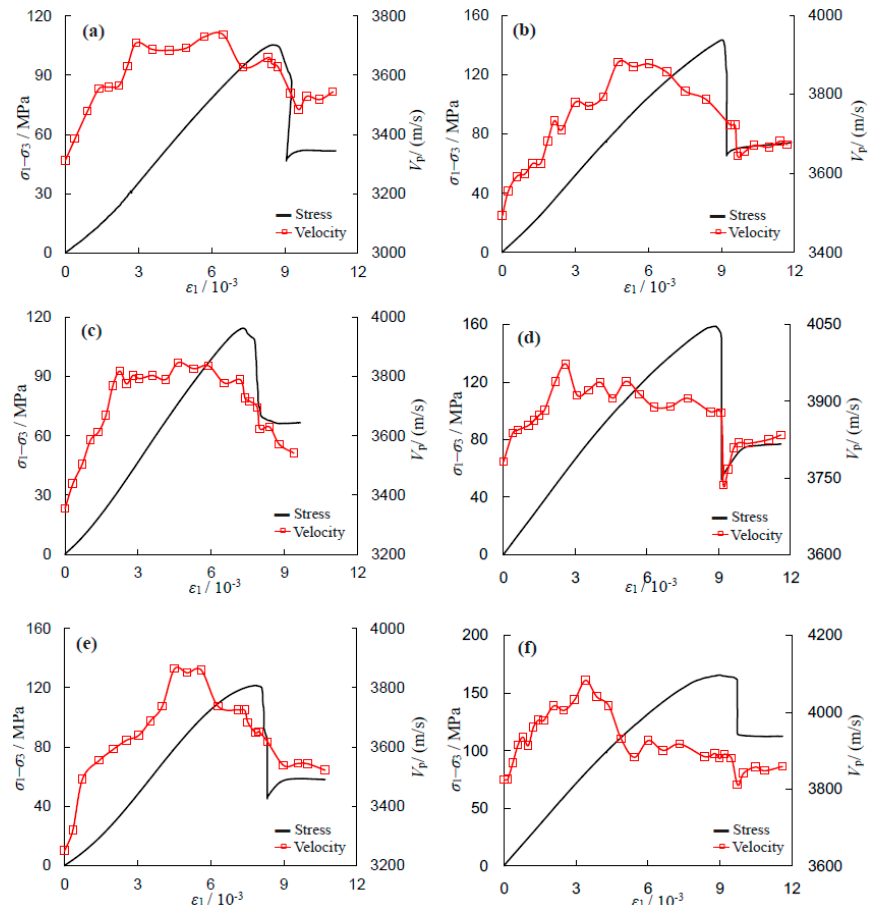
Figure 10. P-wave velocity against axial strain during complete failure process under triaxial compression. ( a ) Water, σ 3 = 10 MPa; ( b ) Water, σ 3 = 60 MPa; ( c ) 10% NaCl, σ 3 = 10 MPa; ( d ) 10% NaCl, σ 3 = 60 MPa; ( e ) 30% NaCl, σ 3 = 10 MPa; and ( f ) 30% NaCl, σ 3 = 60 MPa.